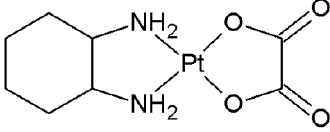
Figure 1. Structure of